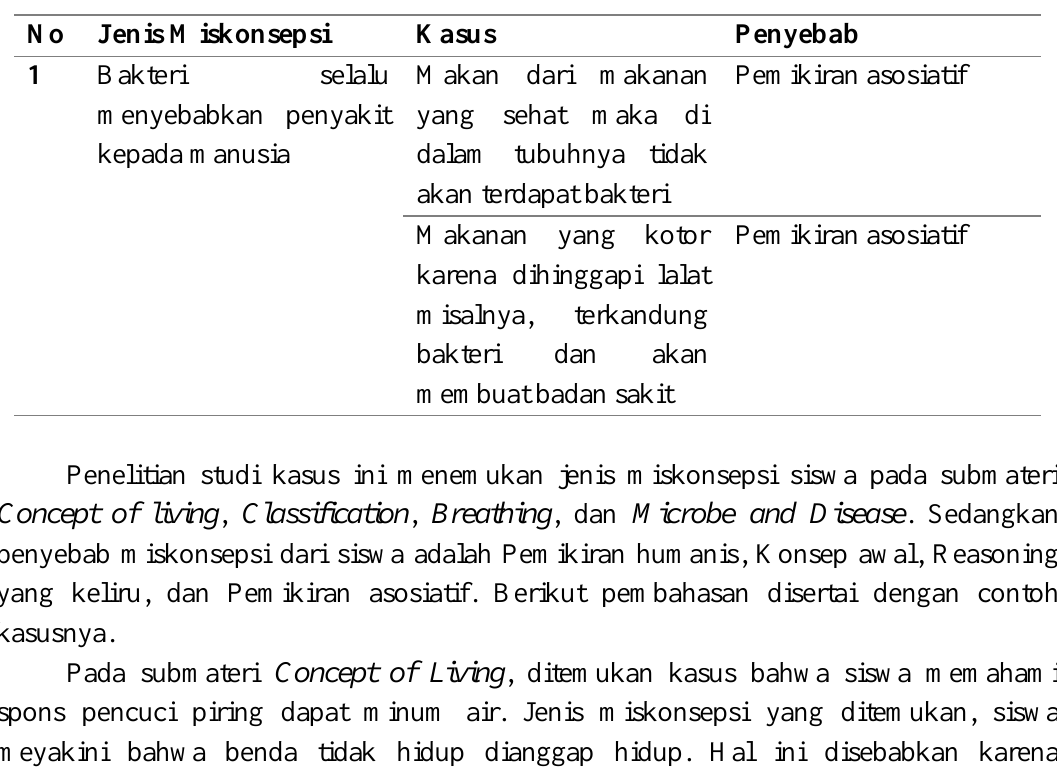
Tabel 4 . Miskonsepsi Siswa SD pada Materi Microbe and